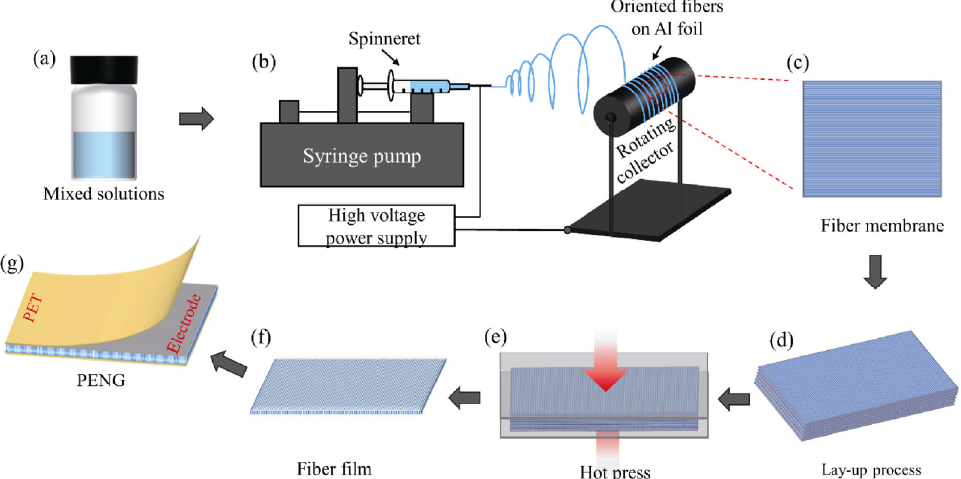
Fig. 1 Abridged general view of the PENG process